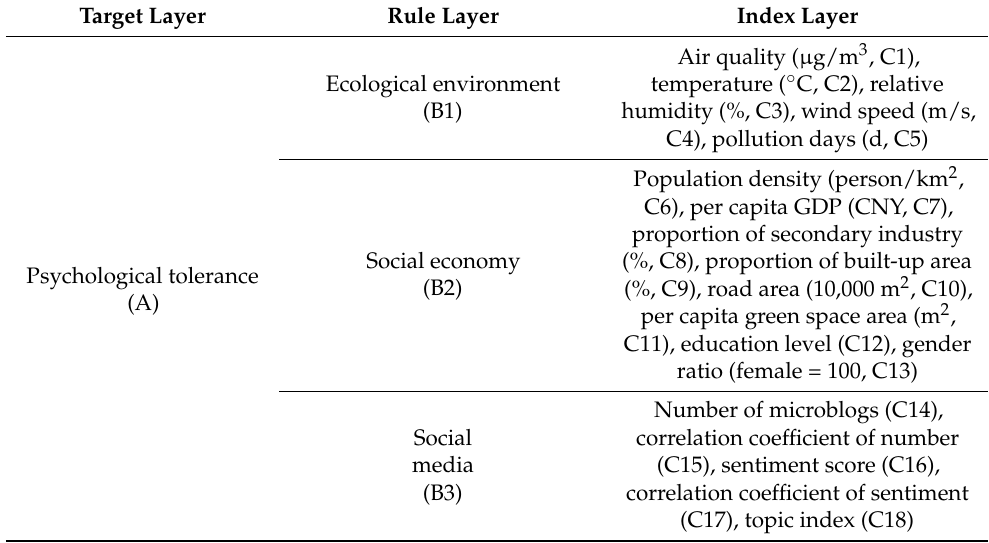
Table 5. Evaluation index